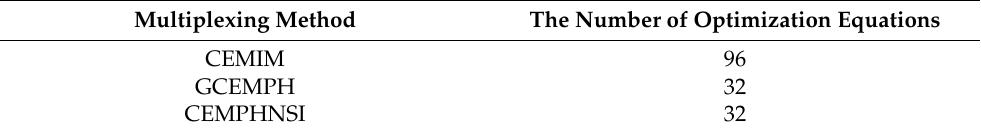
Table 2. The number of optimization equations for different multiplexing methods.